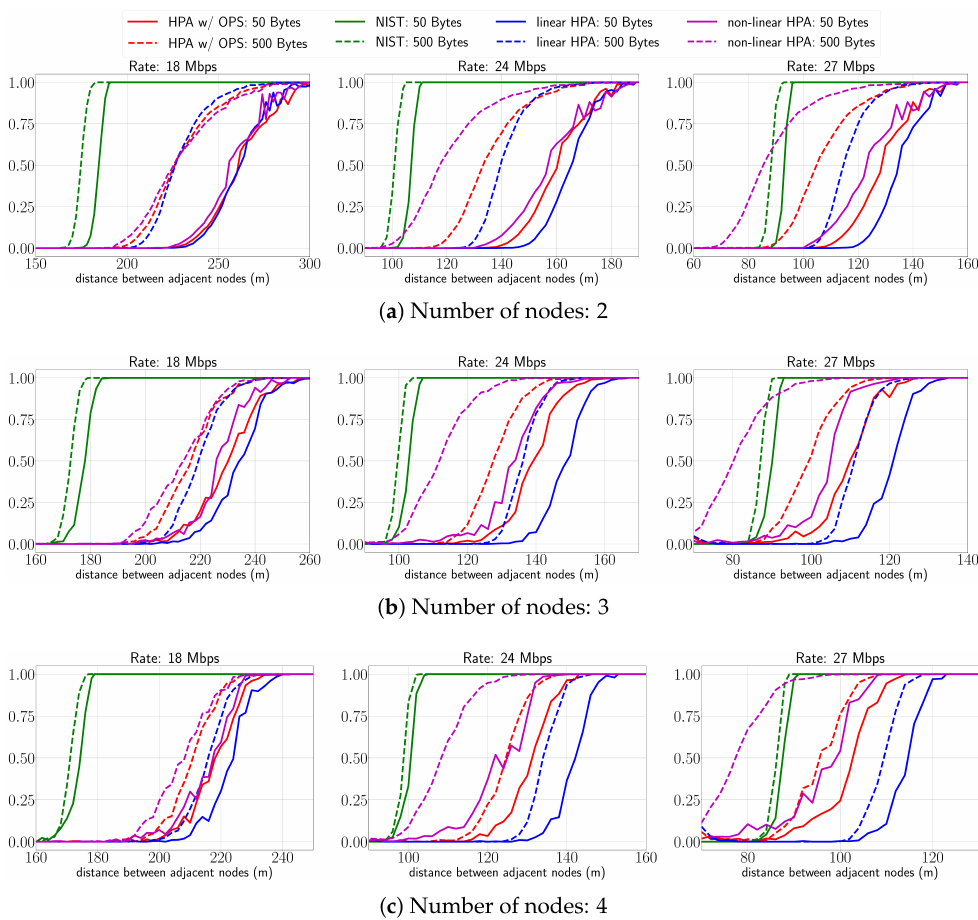
Figure 9. PLR vs. distance for different rates and for different linear chain topologies. ( a ) Number of nodes: 2, ( b ) number of nodes: 3, ( c ) number of nodes: